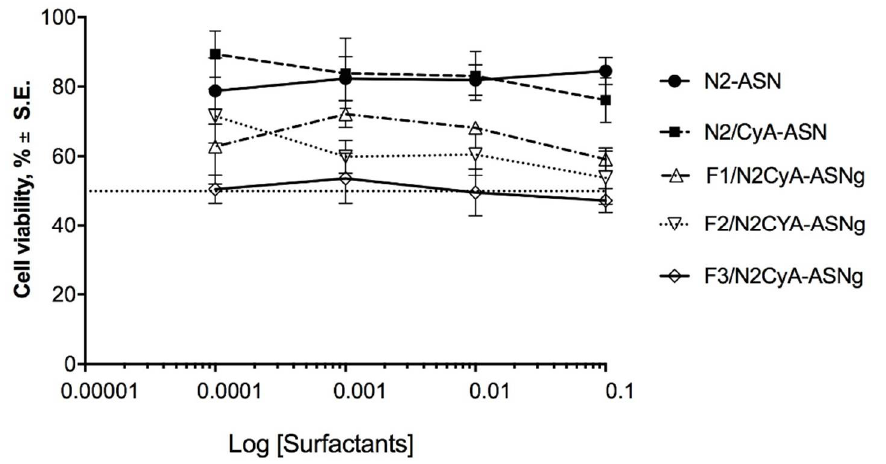
Figure 7. Cytotoxicity of surfactant self-assembling nanomicellar preparations with (N2CyA-ASN) and without (N2ASN) encapsulated CyA and surfactant self-assembling nanomicellar preparations in in situ gelling systems based on different concentrations of GG-LA (Fx/CyA-ASNg) formulations on rabbit corneal epithelial cell line.